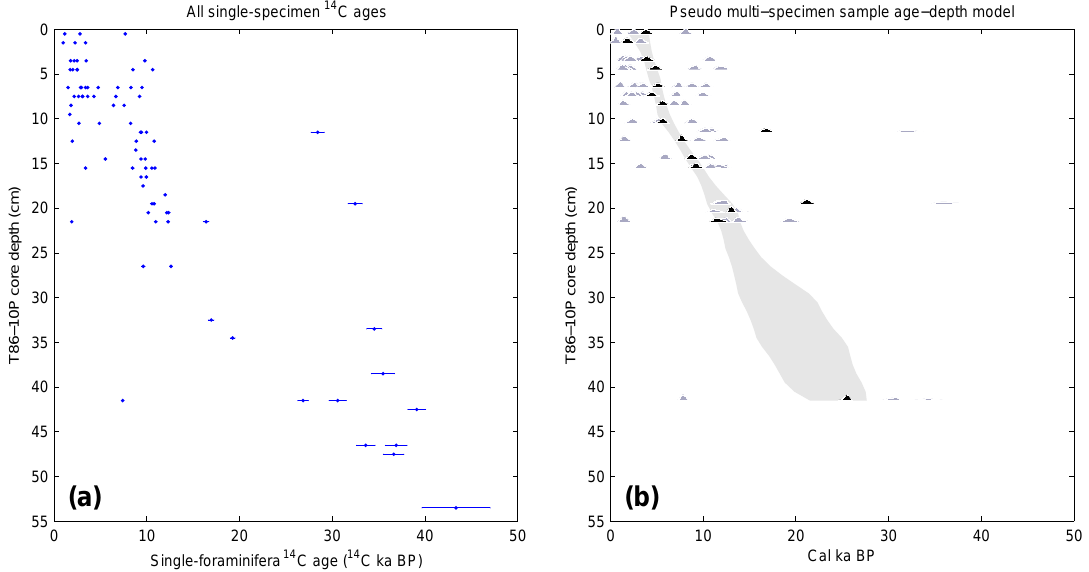
Figure 2. Results of single-foraminifera C. wuellerstorfi 14 C dating in core T86-10P. (a) 14 C determinations (uncalibrated) on single C. wuellerstorfi foraminifera from core T86-10P, with 1 σ measurement uncertainty shown. (b) A demonstration of the concealment of large intra-sample heterogeneity by the long-standing geochronological method. Calibrated single-specimen benthic foraminifera 14 C ages (light blue probability density functions (PDFs); see “Method” section for 14 C calibration process) for all discrete 1cm core depths with three or more subsampled foraminifera. To demonstrate the potential concealment of PDSM by long-standing geochronological methods involving dating of multi-specimen foraminifera samples, we also show the 95% confidence interval (light grey) of a Bacon (Blaauw and Christen, 2011) age–depth model created using calibrated pseudo multi-specimen foraminifera 14 C ages (black PDFs – see Sect.